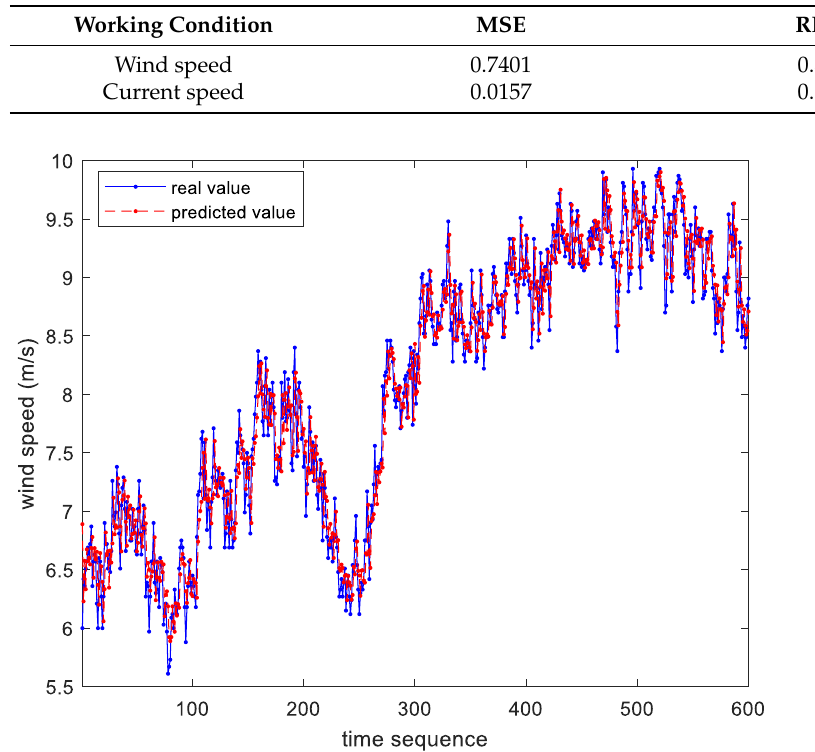
Figure 4. Prediction results of wind speed.